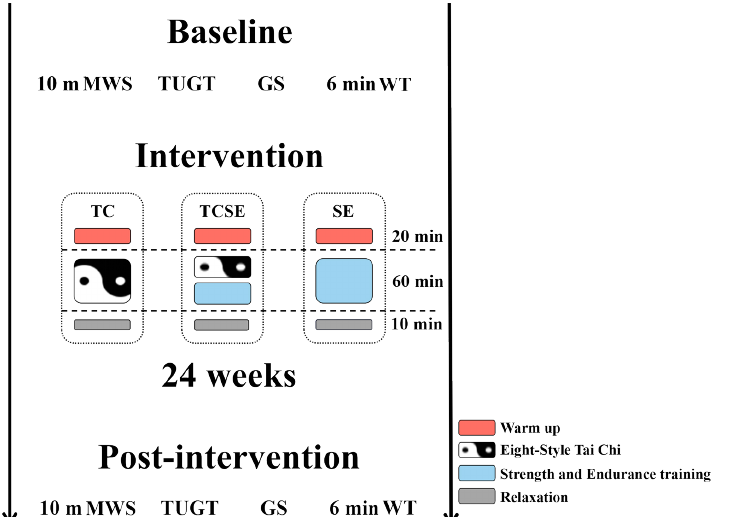
Figure 1. Experimental design. Participants were randomly assigned to the TC, TCSE, and SE intervention groups. Assessment of participants’ ten-meter maximum walking speed, TUGT, grip strength, and the six-minute walk test at baseline and after the 24-week